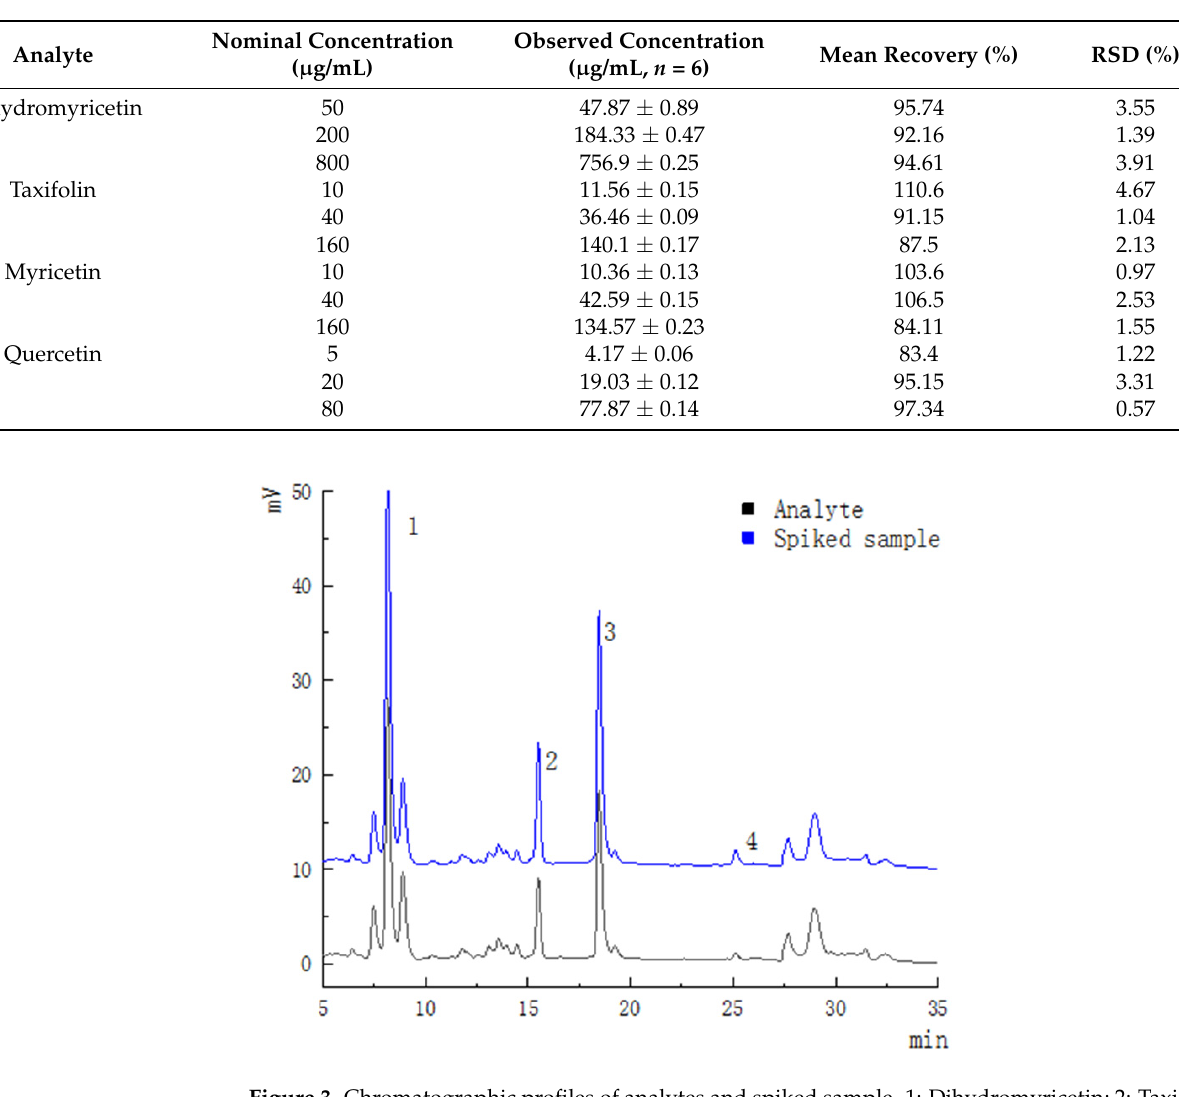
Table 5. Data for recovery and RSD studies of dihydromyricetin, taxifolin, myricetin and quercetin.